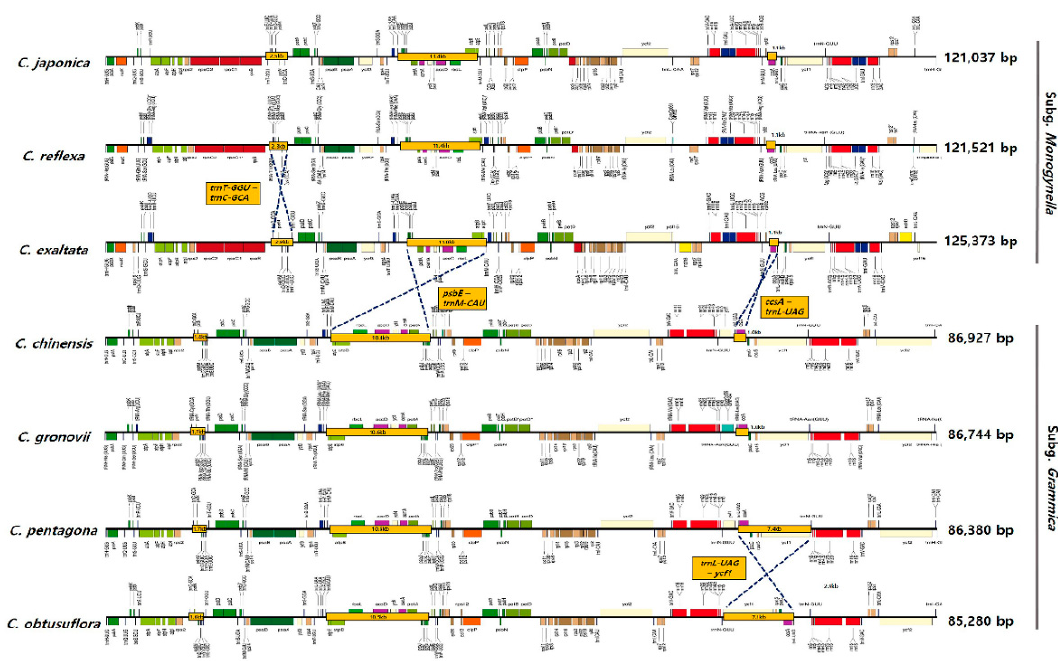
Figure 3. Linear chloroplast genome maps of seven Cuscuta species. Linear maps were drawn using OGDRAW. Yellow boxes indicate inversions. Chloroplast genomes of C. reflexa , C. exaltata , C. gronovii , C. pentagona and C. obtusiflora were downloaded from GenBank.